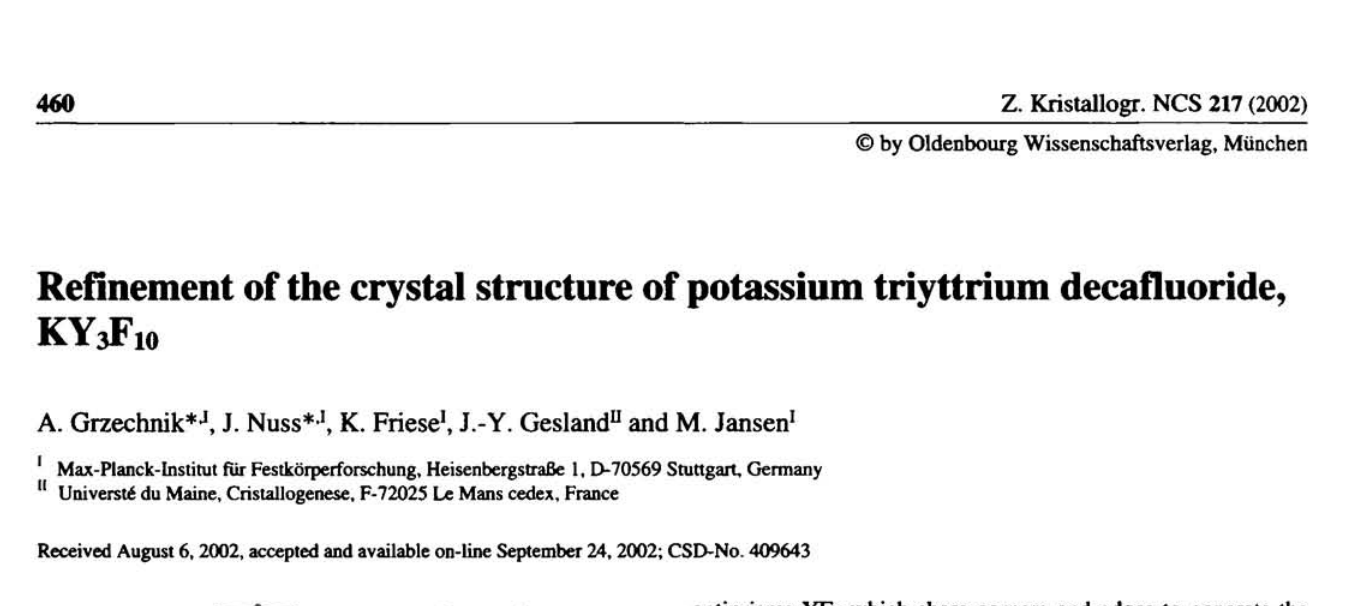
Table 1. Data collection and handling.